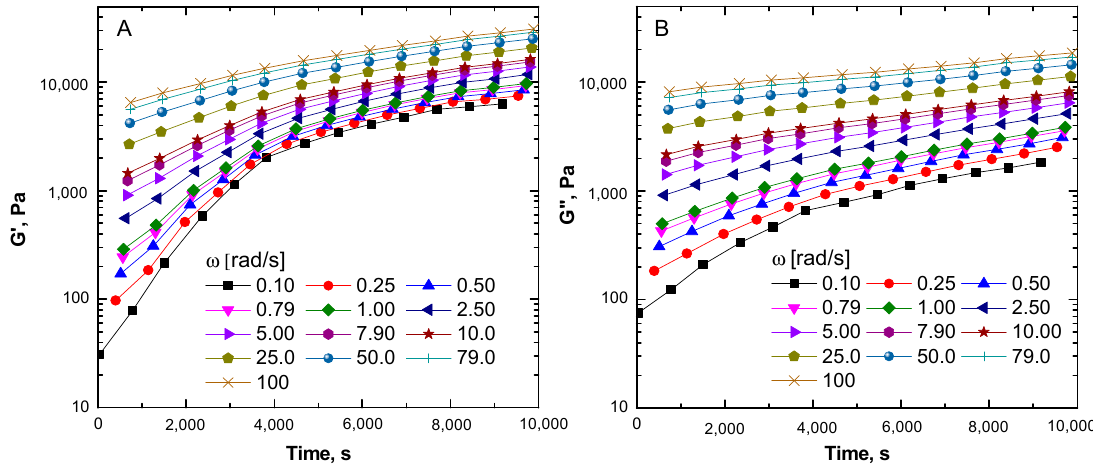
Figure 3. Time-resolved mechanical spectroscopy (TRMS) sweeps for ENR25 at 180 ◦ C: storage modulus ( A ) and loss modulus ( B ).